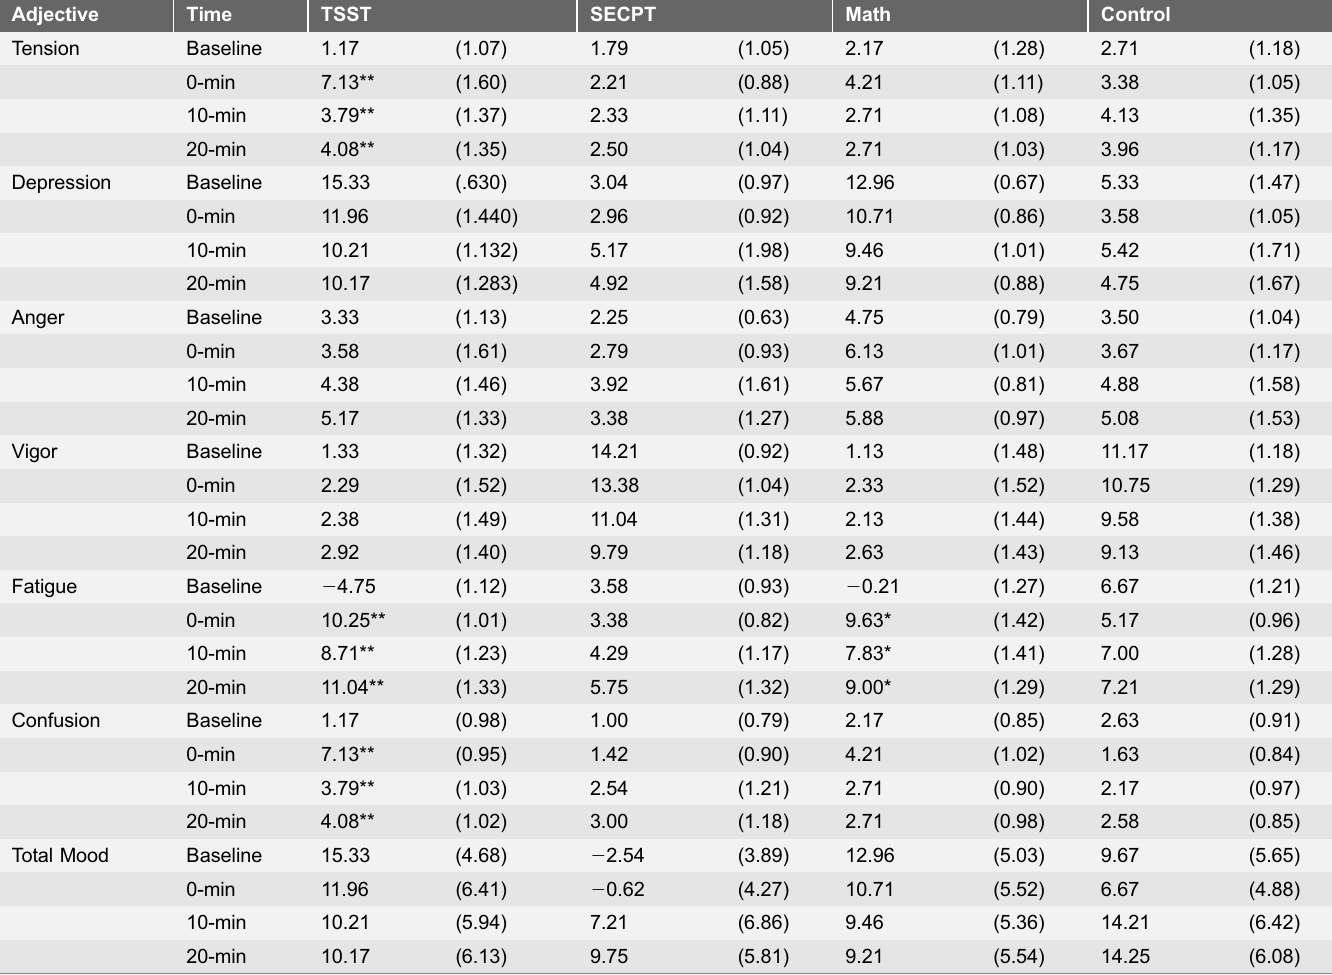
Table 1. Profile of Mood States (POMS) as a function of stress (means and SE) at baseline and 0-, 10- and 20-minutes